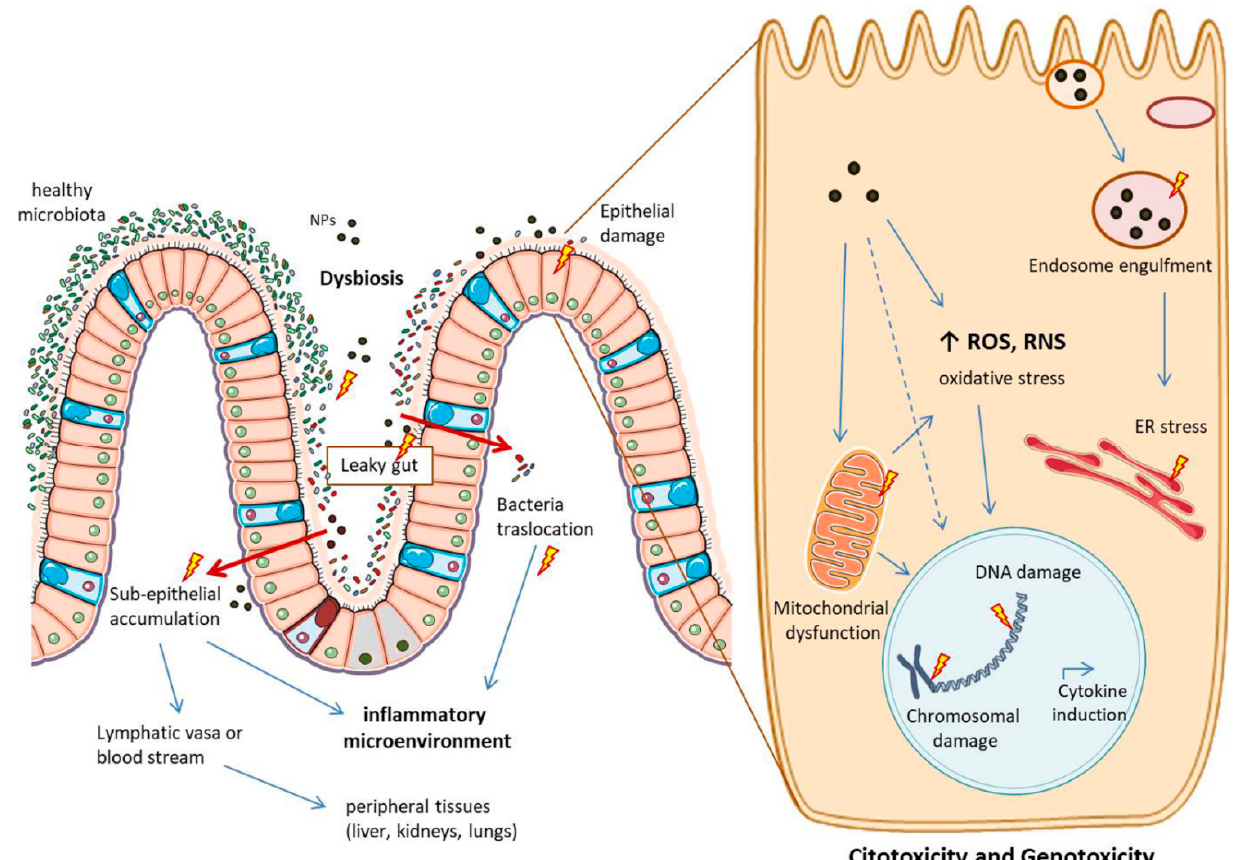
Figure 5. Main potential side effects of metallic NPs in the intestine and at cellular level. NPs can cause dysbiosis and tight junction rearrangements, favouring conditions of “leaky gut”. This can lead to bacteria translocation and NPs accumulation in the sub-epithelium, causing an inflammatory microenvironment. NPs in this space can pass into lymphatic vasa or into the blood stream, potentially reaching peripheral tissues. NPs can also directly harm the epithelium layer causing citotoxicity and genotoxicity once inside the cells. Here they can: accumulate into the endosomes, impair the vesicular trafficking and cause ER (endoplasmic reticulum) stress; increase the production of ROS and RNS, with oxidative stress and mitochondrial dysfunction; final outcomes can be cytokines induction and chromosomal and DNA damage. The image is original and was created with the use of Servier Medical Art modified templates, licensed under a Creative Common Attribution 3.0 Unported License (https://smart.servier.com, accessed on 19 February 2022).